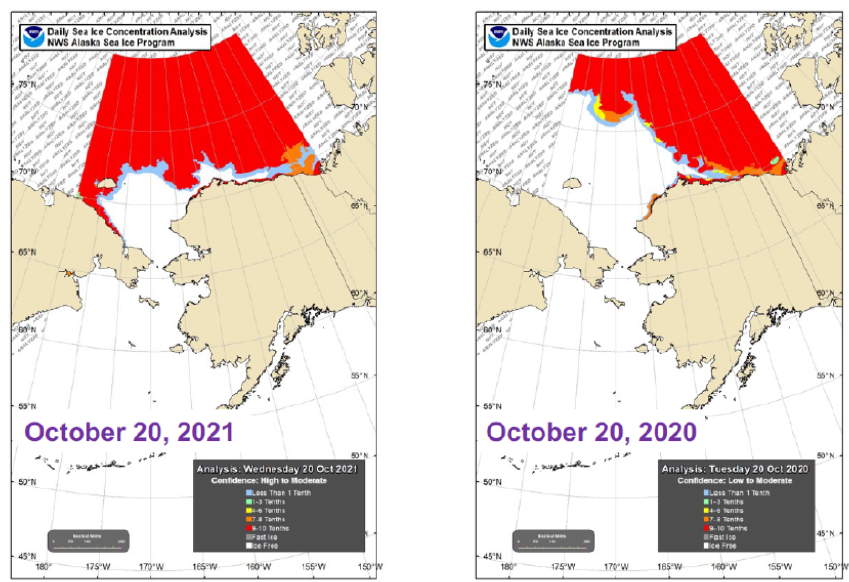
Figure 12. Sea ice coverage on 20 October 2021 (left panel) and 20 October 2020 (right panel). As indicated by the legends in the lower right of each panel, red denotes essentially complete ice coverage while gray areas have low concentrations. Source: NWS Alaska Region Sea Ice Desk.